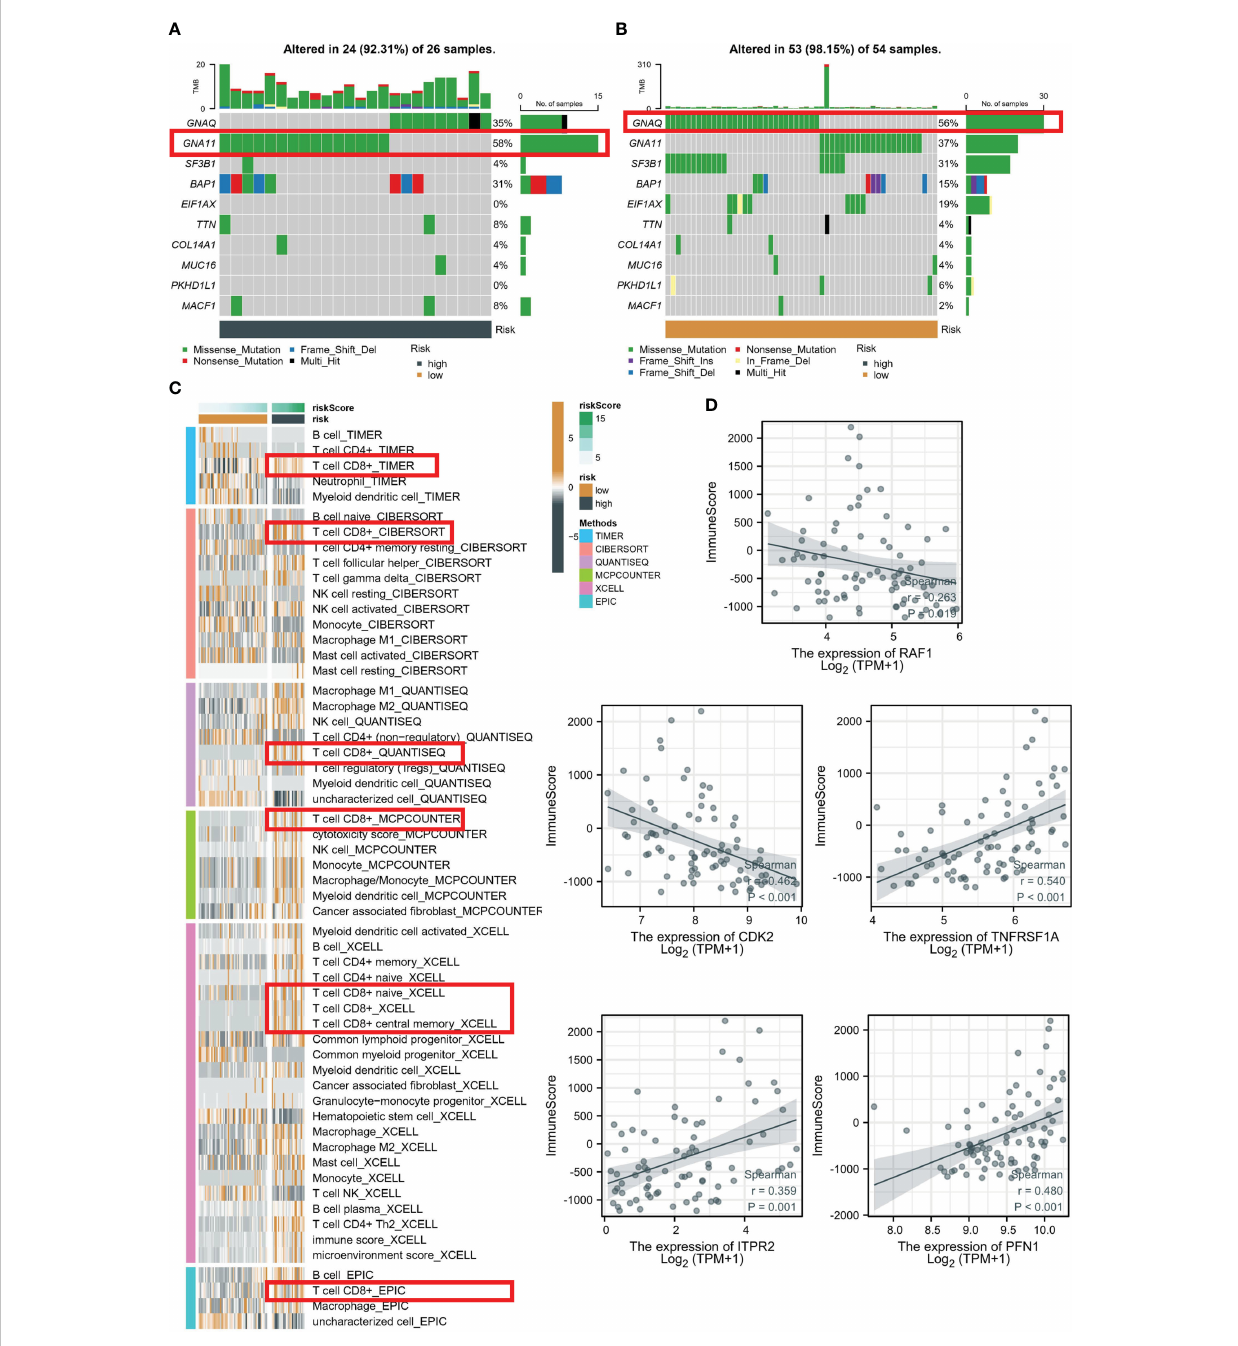
FIGURE 6 Evaluation of TME in high- and low-risk groups. Top 10 gene mutations in high- (A) and low-risk (B) groups. (C) Analysis based on different algorithms showed immune cell in fi ltration in low-risk and high-risk groups. (D) Pearson correlation analysis between fi ve PRGs and immune